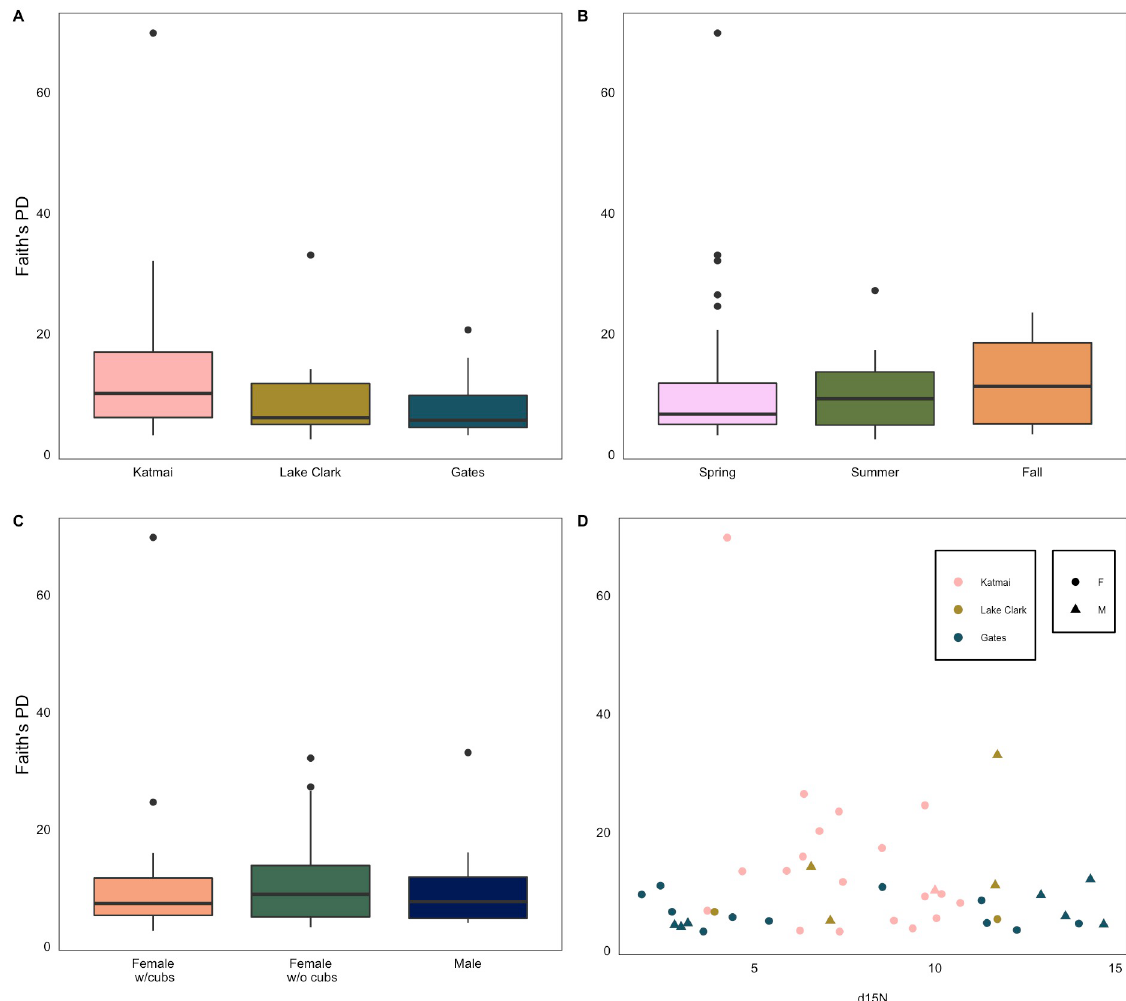
Fig 3. Boxplots summarizing Faith’s Phylogenetic Diversity (PD). For each A) park; B) season; C) reproductive group; and D) scatterplot of Faith’s PD versus diet (based on nitrogen stable isotope analysis of bear hair samples).